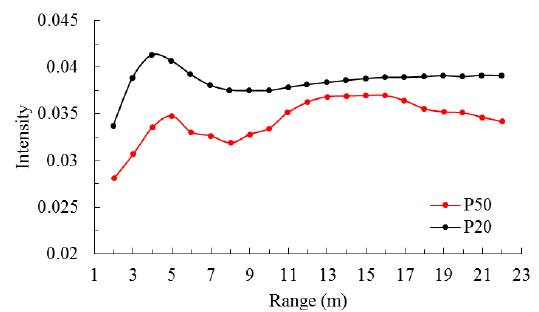
Figure 1. Intensity – range relationships for the P50 and the P20 TLS